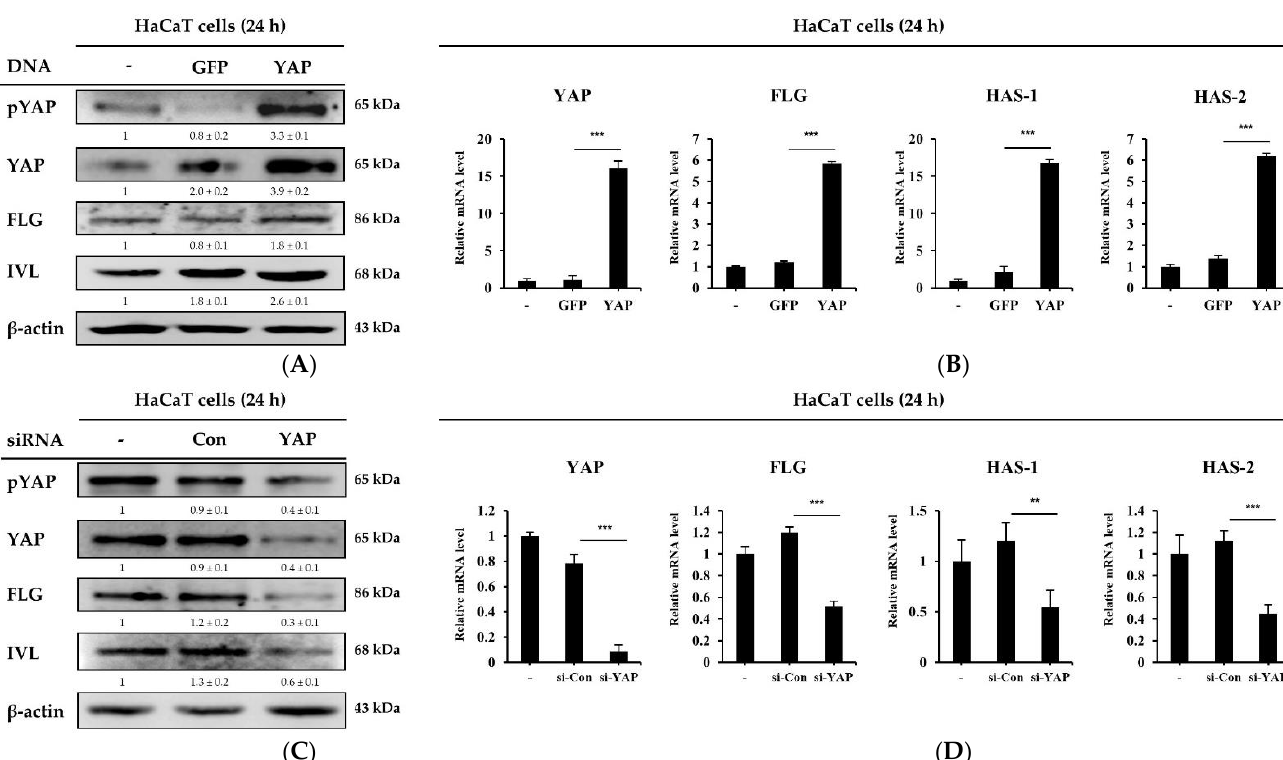
Figure 4. Skin barrier and moisturizing factors are mediated by YAP. ( A , B ) HaCaT cells were transfected with a plasmid overexpressing either green fluorescent protein (GFP; a control) or YAP, and incubated for 24 h. Cells were harvested and the expression of pYAP, YAP, FLG, and IVL was evaluated by Western blotting and the expression levels of YAP , FLG , and HAS-1 , 2 were determined by qRT-PCR. For Western blotting, β -actin was used as a loading control. ( C , D ) HaCaT cells were transfected with control small interfering RNA (siRNA) or YAP siRNA, and further incubated for 24 h. The expression of pYAP, YAP, FLG, and IVL was determined at the protein level, and the expression of YAP , FLG and HAS-1, 2 was analyzed at the mRNA level. Numerical values on the blots represent DU. The control was normalized to 1 DU. Data are the means ± SD and represent three independent experiments. ** p < 0.01, *** p < 0.001.